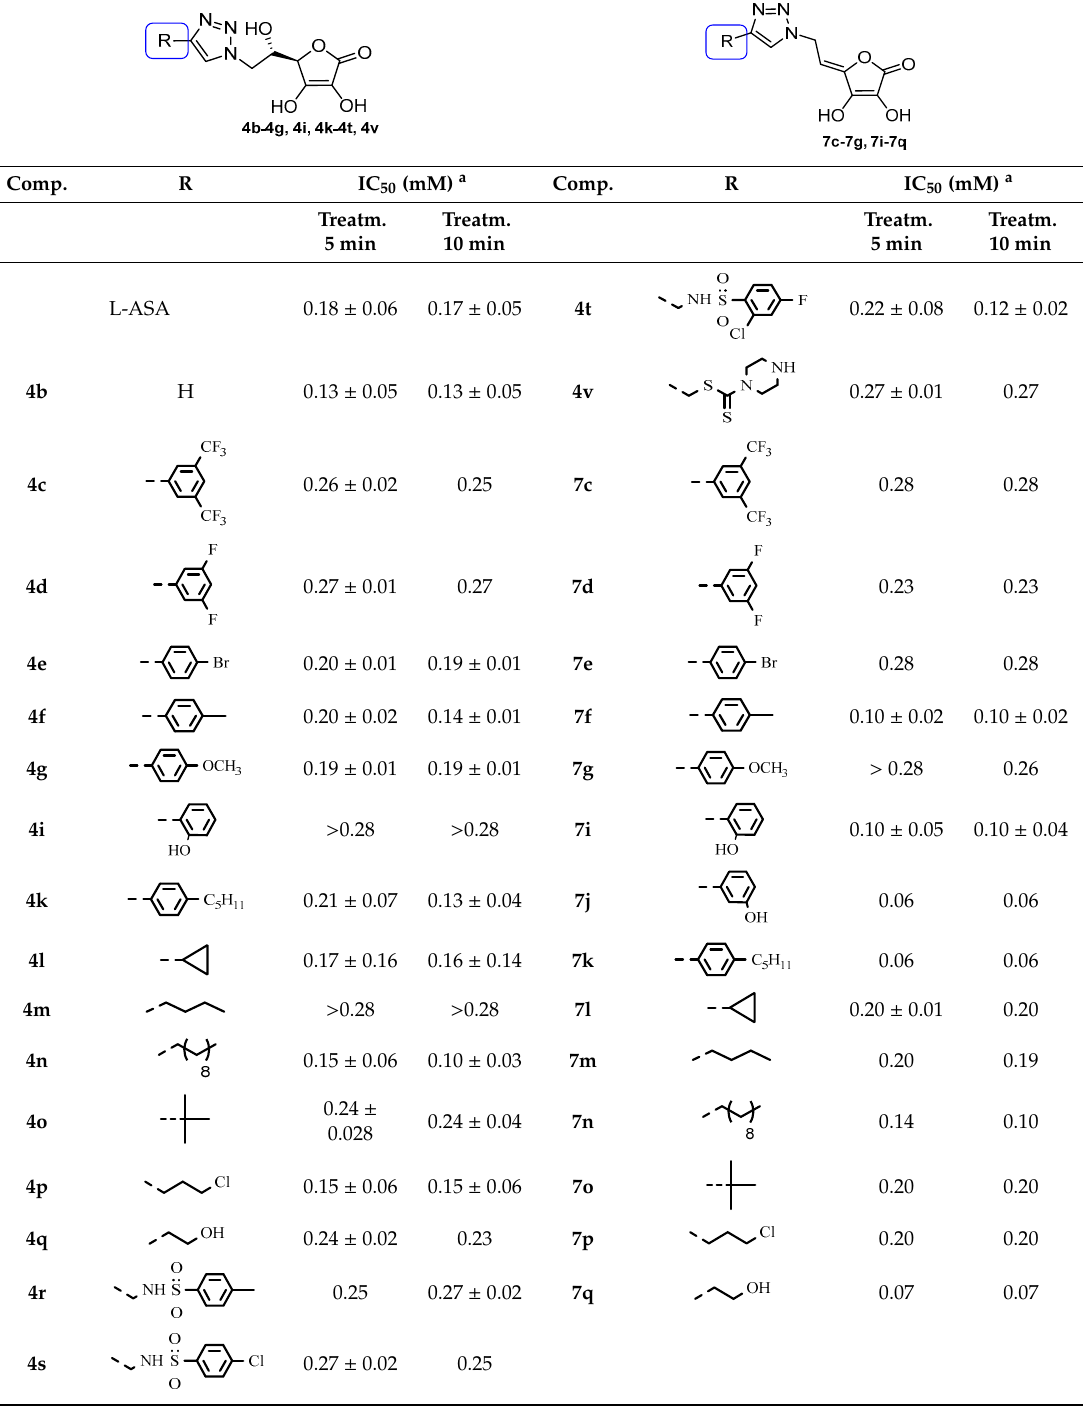
Table 1. The scavenging activity of L-ascorbic acid derivatives assessed by DPPH test. Results are Int. J. Mol. Sci. 2019 , 20 , x FOR PEER REVIEW presented as IC 50 values (mM) of DPPH • inhibition after 5 and 10 min treatments.